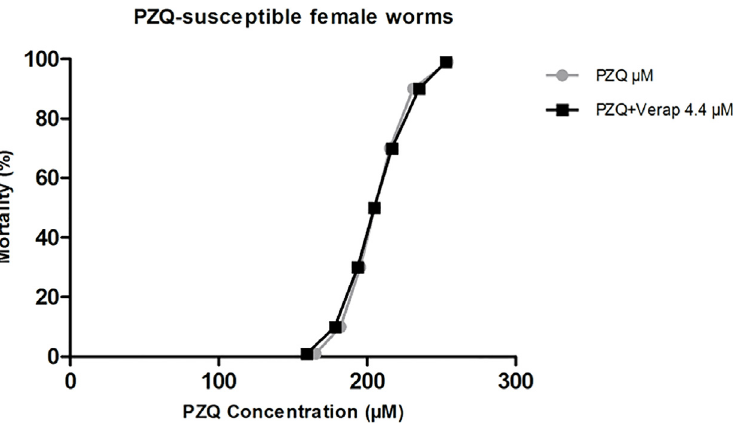
Fig 11. Mortality trends S . mansoni adult females PZQ-susceptible exposed to PZQ in the presence of Verapamil. The mortality levels to 4.4 μ M Verap is represented by a survival curve. Additionally, the survival curve of parasites unexposed to Verapamil is also represented. The Probit regression model was used with a 95% of confidence.